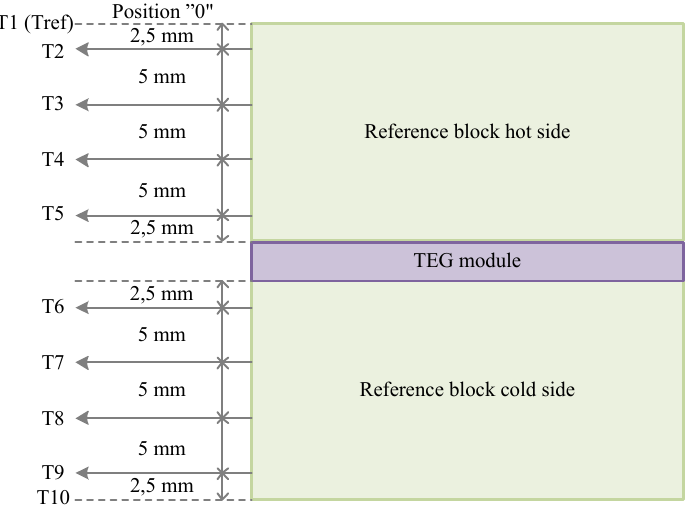
Figure 3. Placement of the thermocouples ( T 2 -T 9 ) in the reference blocks.